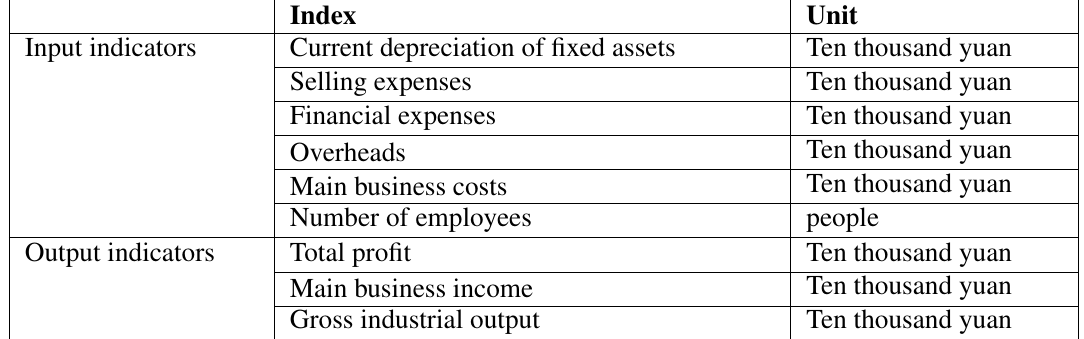
Table 1 Input–output evaluation indicators